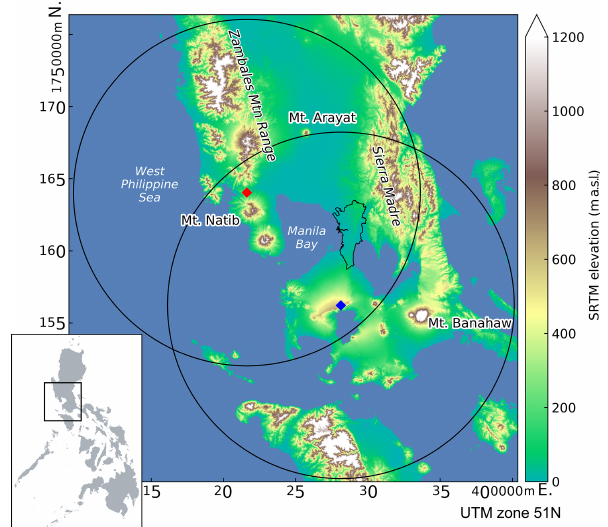
Figure 1. Locations of the SUB (red diamond) and TAG (blue dia- mond) radars, showing the 120km range with the region of overlap. Metropolitan Manila is outlined in black beside Manila Bay. The relative location of the study area with respect to the Philippines is shown in the